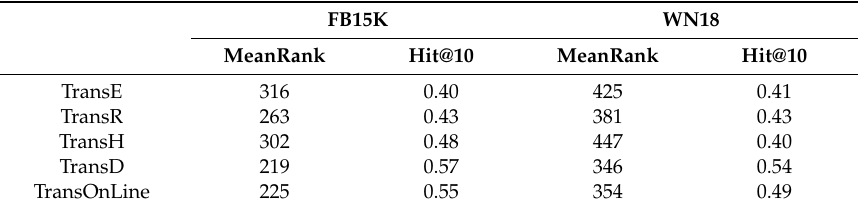
Table 2. The result of performance on these methods.